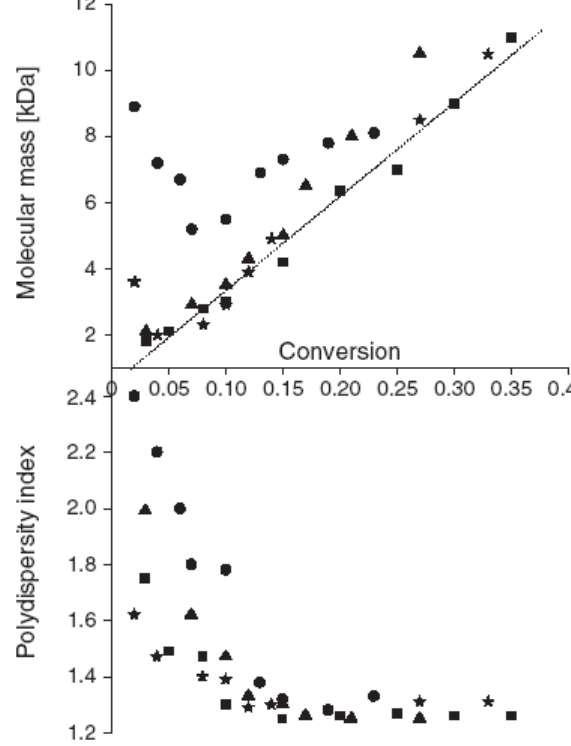
Figure 9 . Plots of Mn versus conversion, Ð versus conversion, and ln([M]/[M0]) versus time for the polymerization of styrene at 90 °C initiated with RS/SR - 7 ( ● ); RS/SR - 7Zn(hfac) 2 ( ■ ); in situ RS/SR - 7Zn(hfac) 2 ( RS/SR - 7 + 0.5 equiv. Zn(hfac) 2 ) (  ); RS/SR - 7 + 10 equiv. Zn(hfac) 2 ( ▲ ),